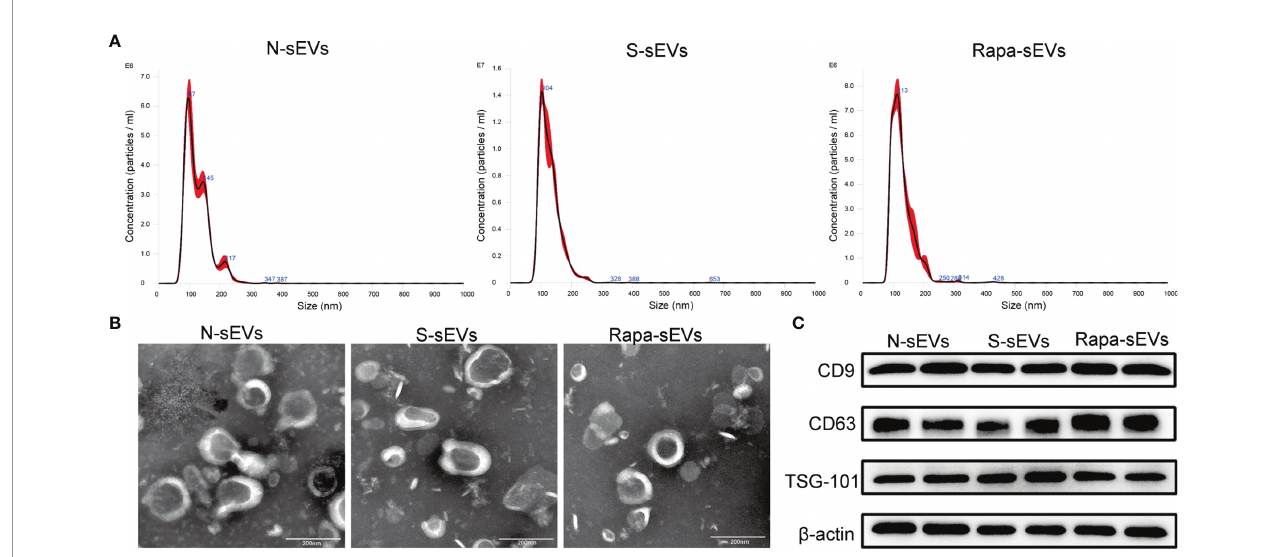
FIGURE 2 | Identi fi cation of sEVs. (A) NTA displayed that the diameters of most sEVs in each group were around 100nm. (B) TEM showed that sEVs in each group were 50 – 200nm disc-like vesicles with bilayer membrane. (C) Western blot analysis showed that sEVs of all groups express CD9, CD63, and